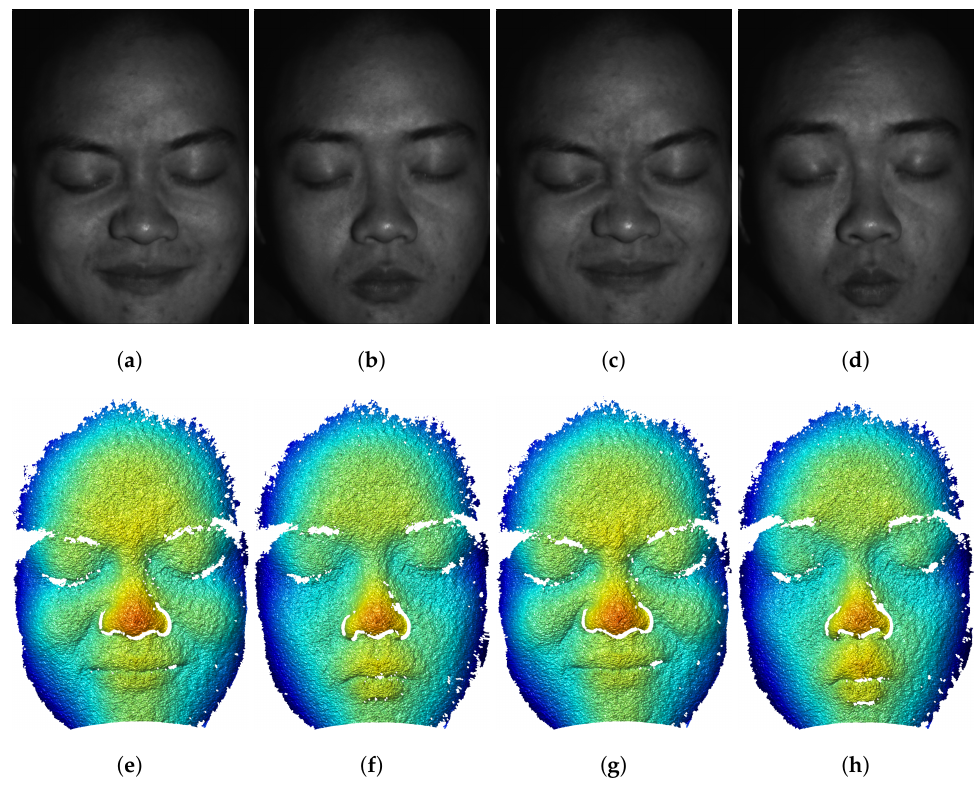
Figure 11. Typical 3D frames of capturing a moving face at 100 Hz (Video S1). ( a – d ) Texture images of the face. ( e – h ) 3D geometry of ( a – d